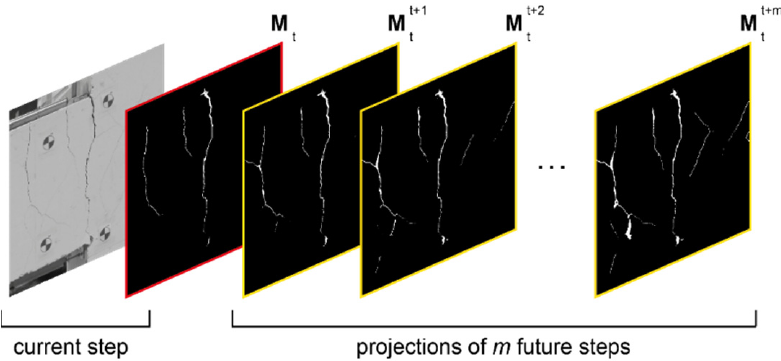
Figure 15. A set of crack masks corresponding to cycle t used for temporal data fusion.